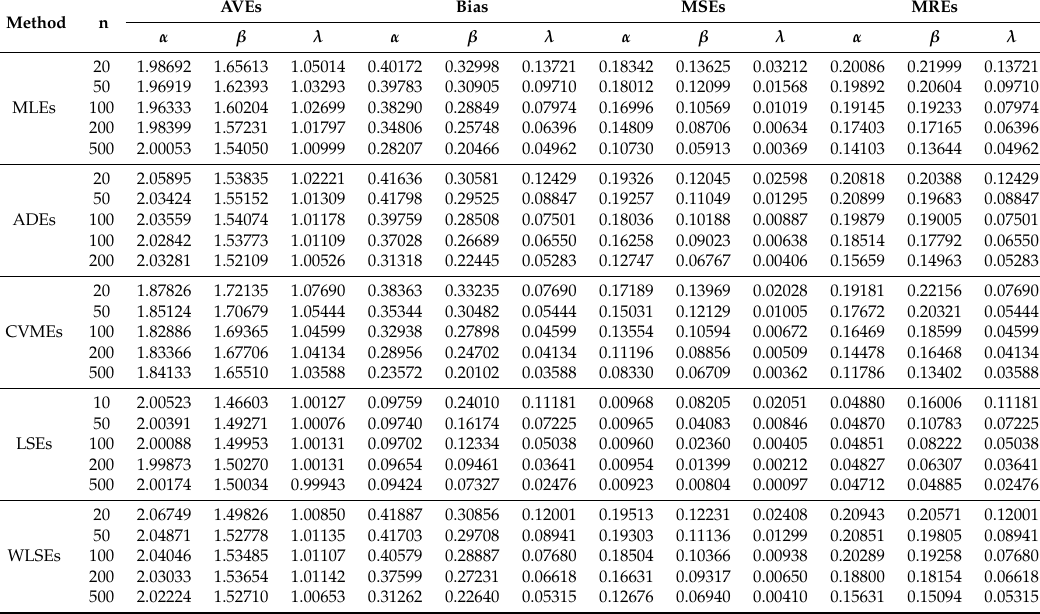
Table 2. Simulation values of the AVEs, biases, MSEs, and MREs for ( α = 2, β = 1.5, λ = 1 )